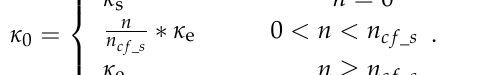
Table 1. Physical parameters of metal oxide materials [22,31 – 35].